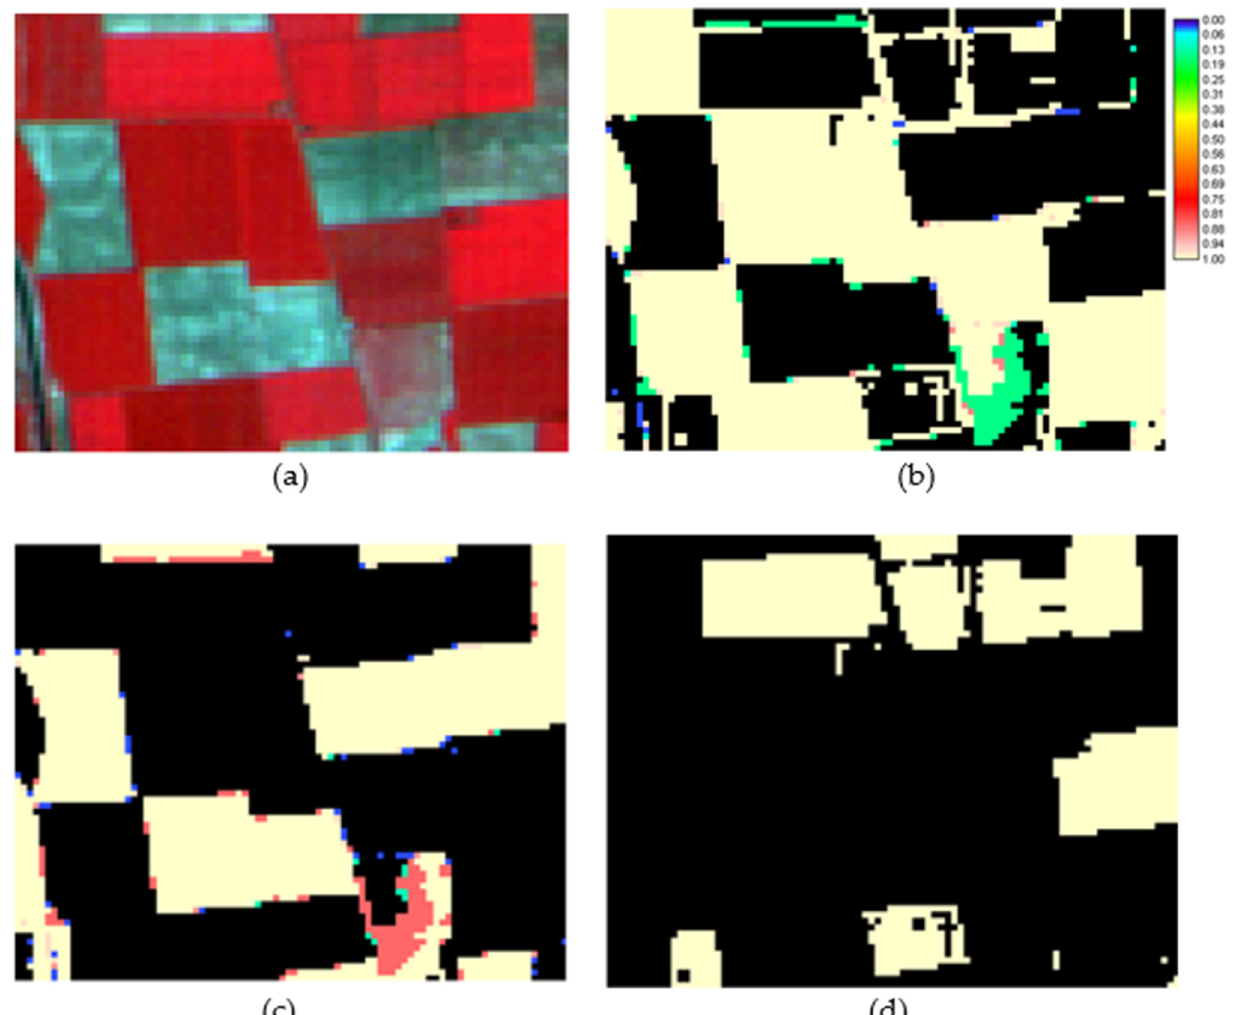
Figure 2. Spatial information on class allocation quality generated from the latent class analysis. ( a ) false colour SPOT HRV image of test site, ( b ) posterior probability to wheat, ( c ) posterior probability to sugar beet and ( d ) posterior probability to barley. Image copyright CNES (2020), reproduced by GMF under licence from SPOT Image.